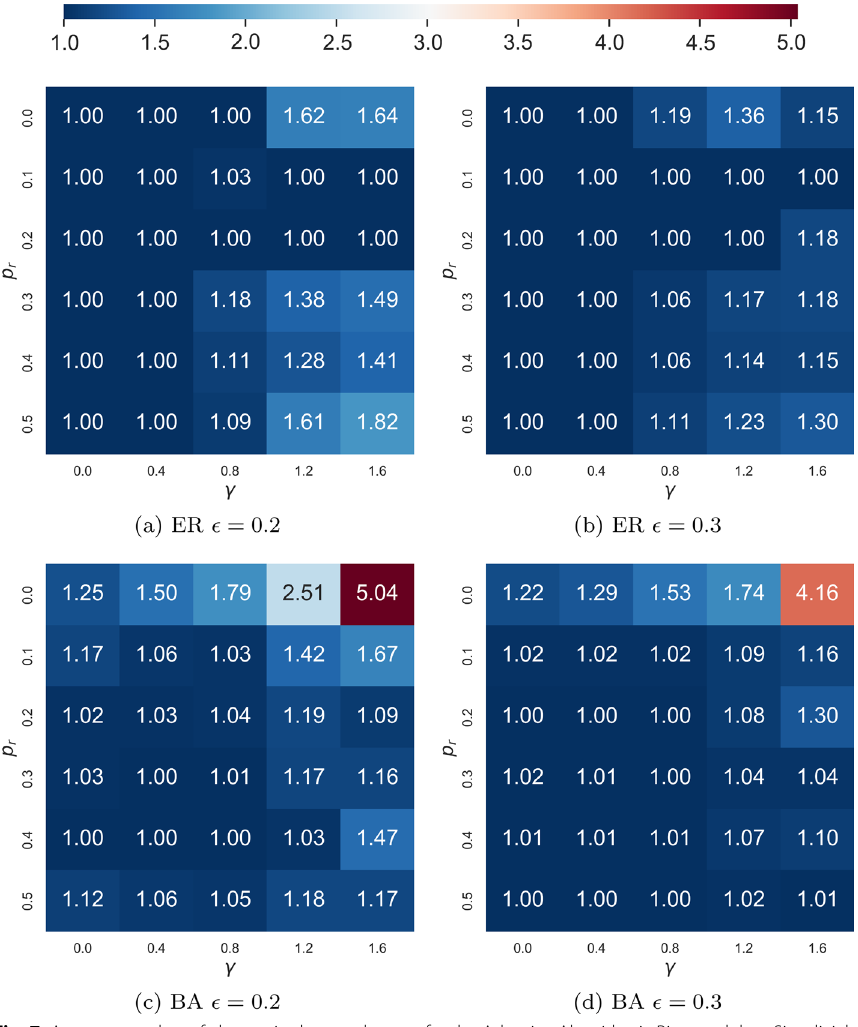
Fig. 7 Average number of clusters in the steady-state for the Adaptive Algorithmic Bias model on Simplicial Complexes. Average number of clusters in the final state for the Adaptive Algorithmic Bias model on Simplicial Complexes as a function of γ and p r for a ǫ = 0.2 , b ǫ = 0.3 and c , d in a scale-free Barabási–Albert graph. These values are averaged over 30